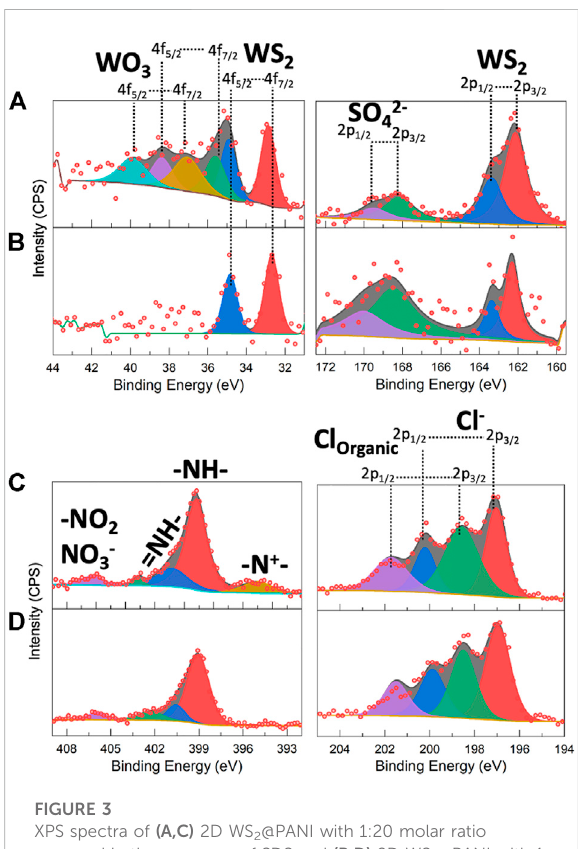
FIGURE 3 XPS spectra of (A,C) 2D WS 2 @PANI with 1:20 molar ratio prepared in the presence of SDS and (B,D) 2D WS 2 @PANI with 1: 20 molar ratio prepared in the presence of NaCh in the W 4f, S 2p (top panels) and N 1s and Cl 2p (bottom panels)